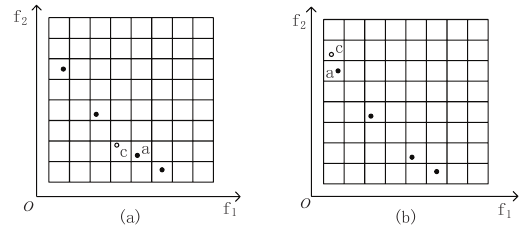
Fig. 4. Box weak dominance